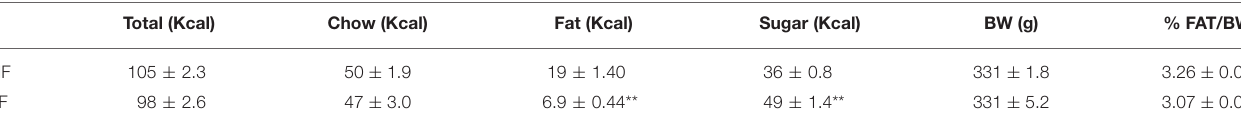
TABLE 4 | Characteristics of low fat and high fat consumers over 1 week of fcHFHS diet. Total